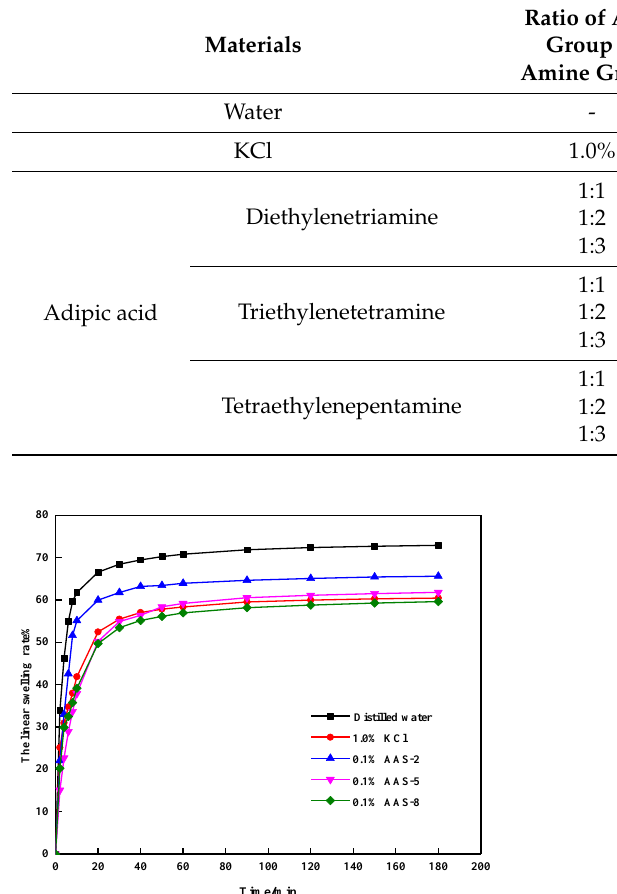
Figure 2. Screening of the various types of inhibitors.